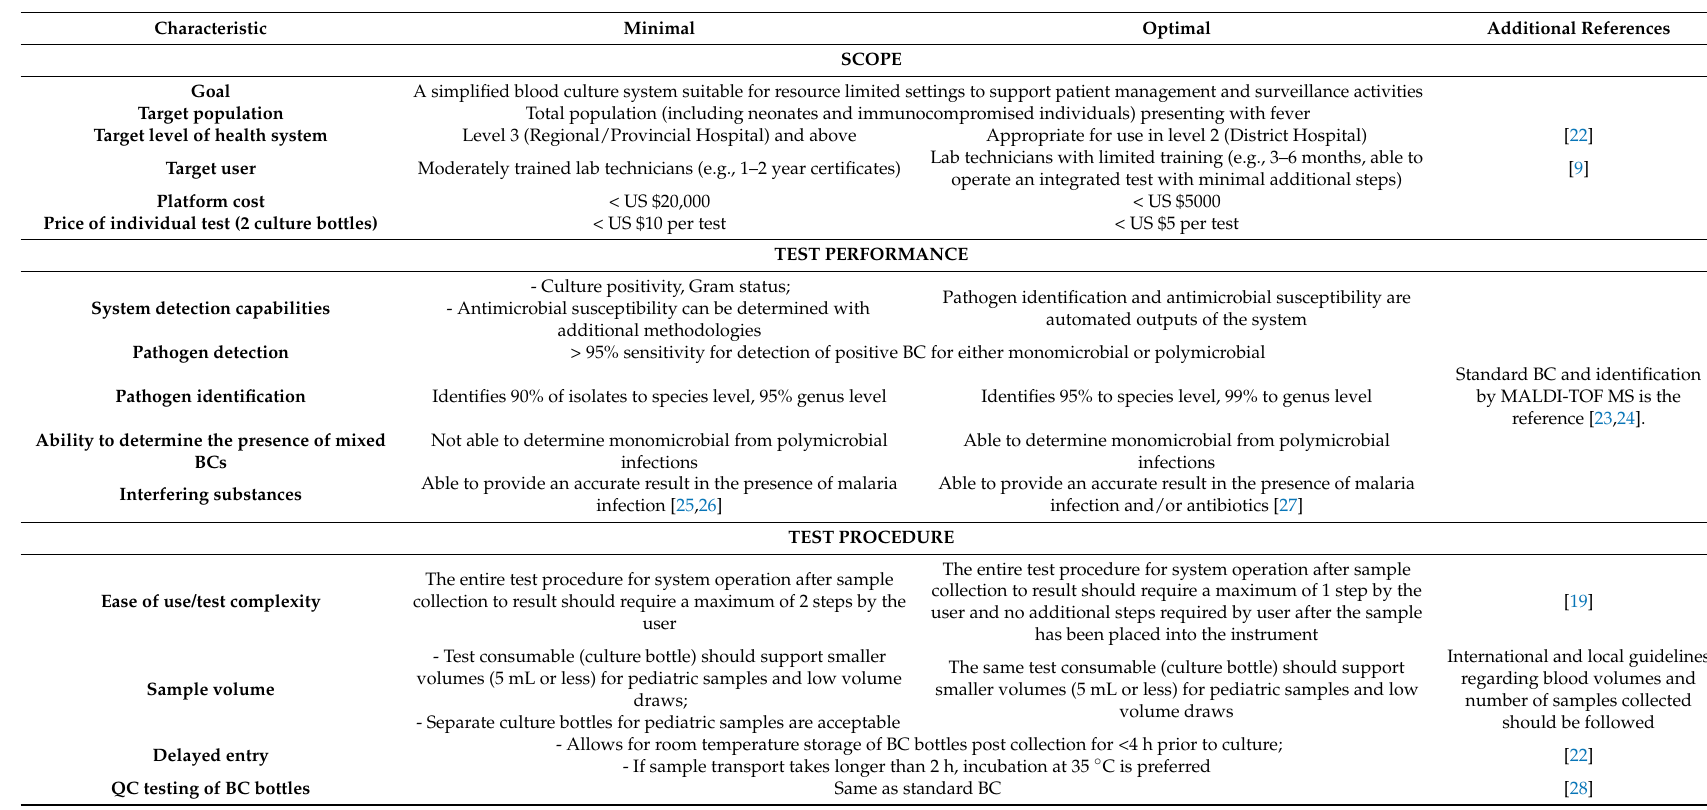
Table 3. Proposed target product profile for a simplified BC system based on stakeholder input and international